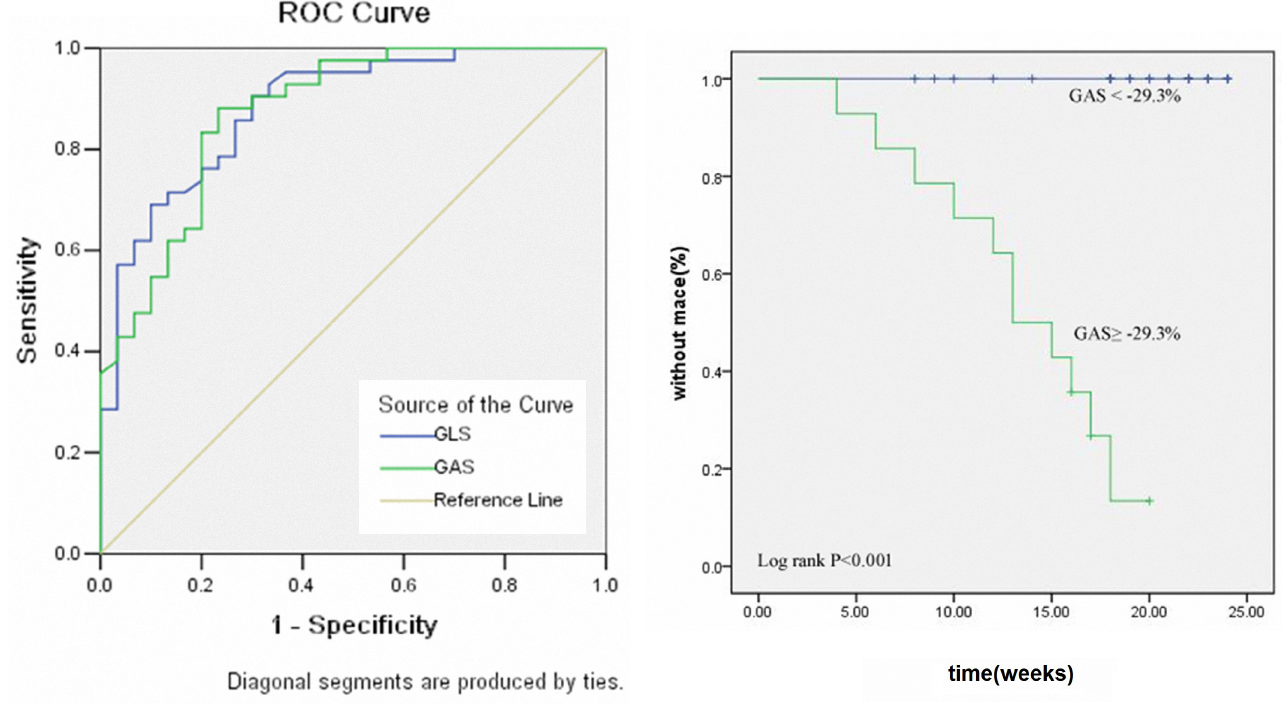
Fig. 2 - Receiver operating characteristic (ROC) curve of global longitudinal strain (GLS) and global area strain (GAS) markers for diagnosis of patients with coronary microvascular dysfunction.